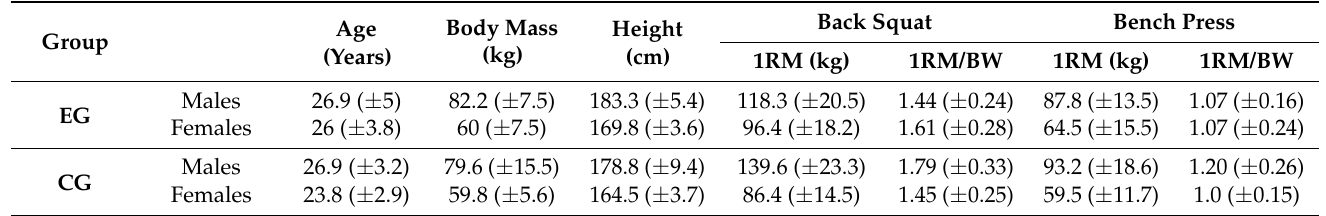
Table 1. Anthropometric characteristics and strength levels (mean ± SD). EG = experimental group; CG = control group.